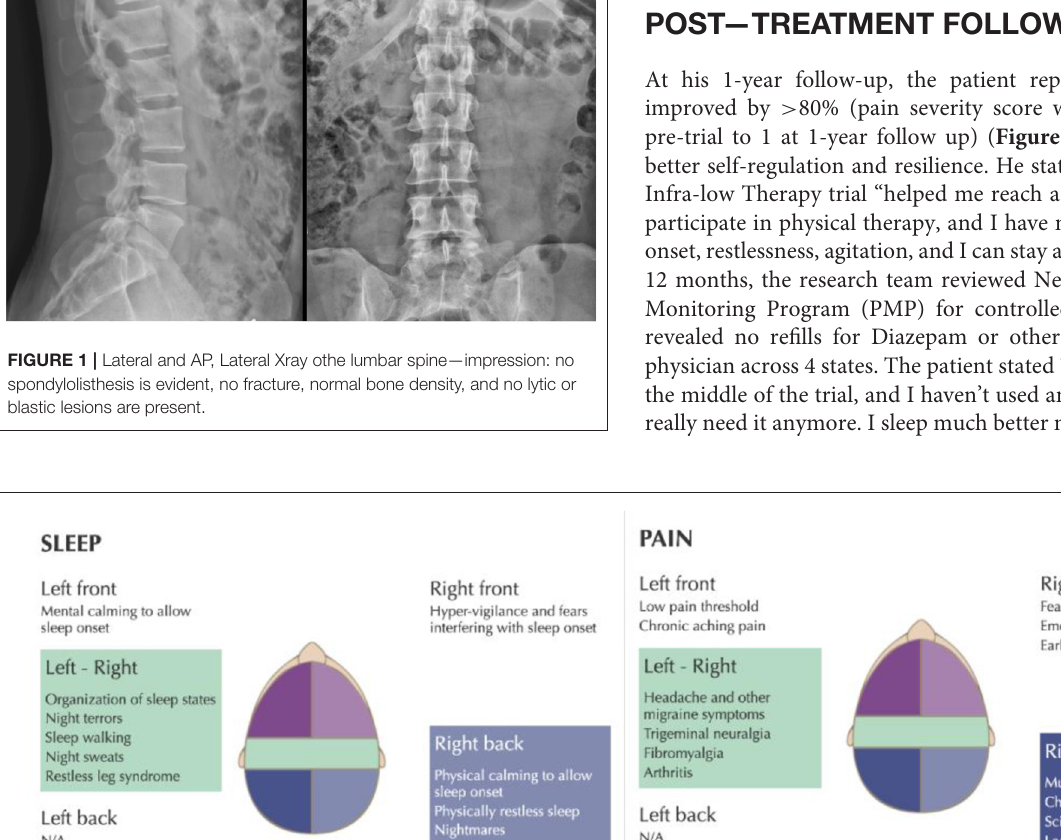
Frontiers in Human Neuroscience |